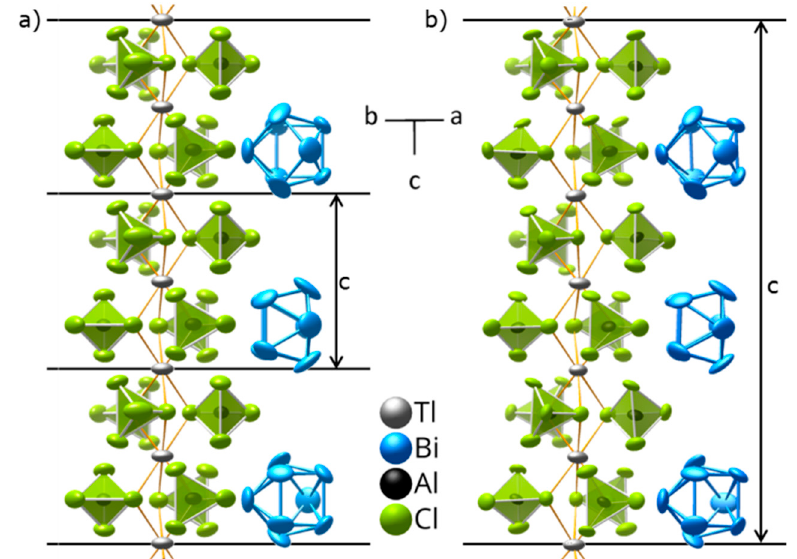
Figure 4. Sections of the crystal structures of (Bi 8 )Tl[AlCl 4 ] 3 at room temperature ( a ) and 170 K ( b ) along [110] showing all three possible orientations of the Bi 82+ polycation over the length of 3 c 296K = c 170K . Ellipsoids comprise 90% of the probability density of the atoms.